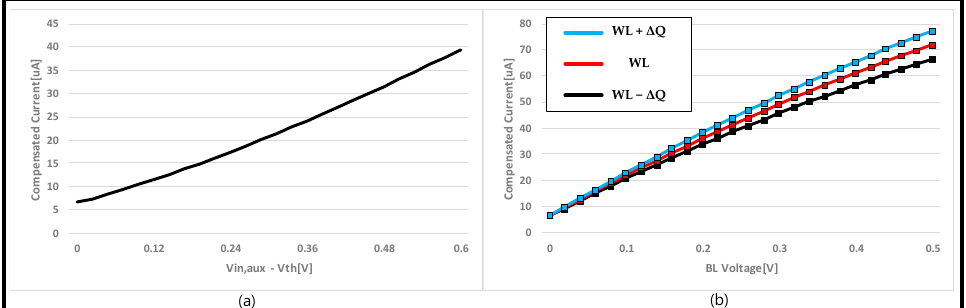
Figure 9. ( a ) Current response of the auxiliary current path and ( b ) total cell current.